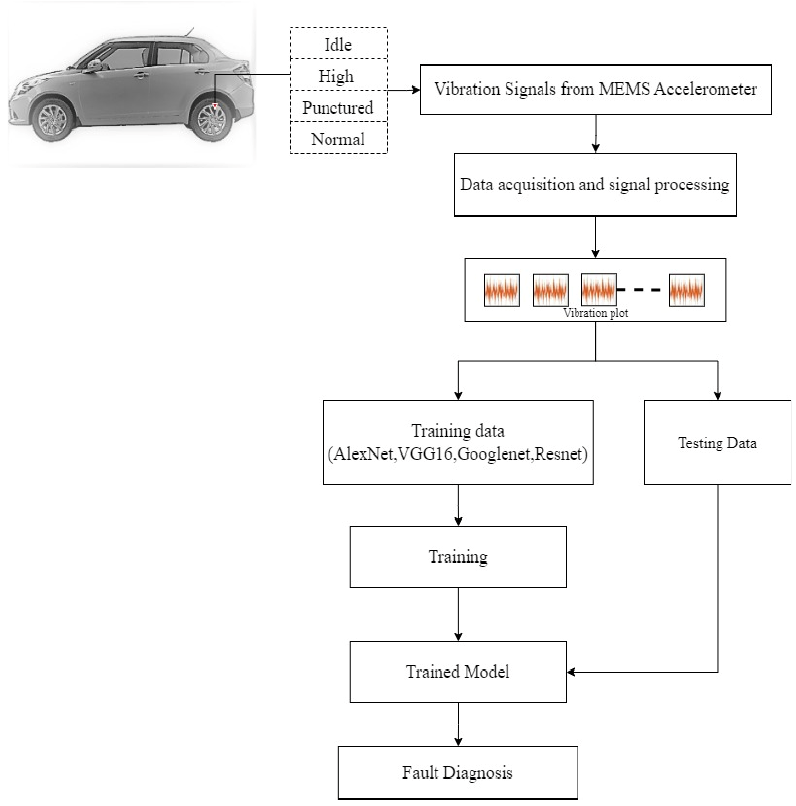
Figure 2. Overall methodology of TPMS using a deep learning method.